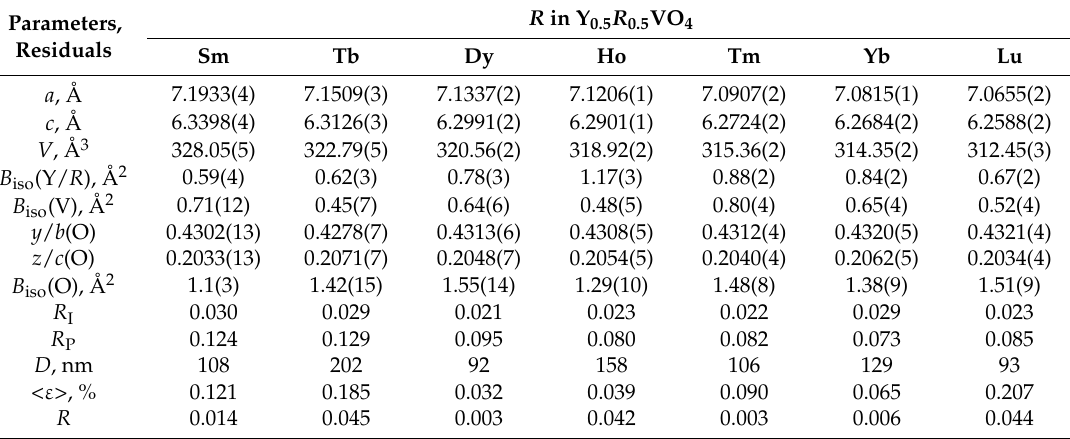
Table 1. Lattice parameters, fractional coordinates and isotropic adp’s in Y 0.5 R 0.5 VO 4 series and microstructural parameters of corresponding powders. Space group I 4 1 / amd ; Y( R ) in 4 a (0 3/4 1/8); V